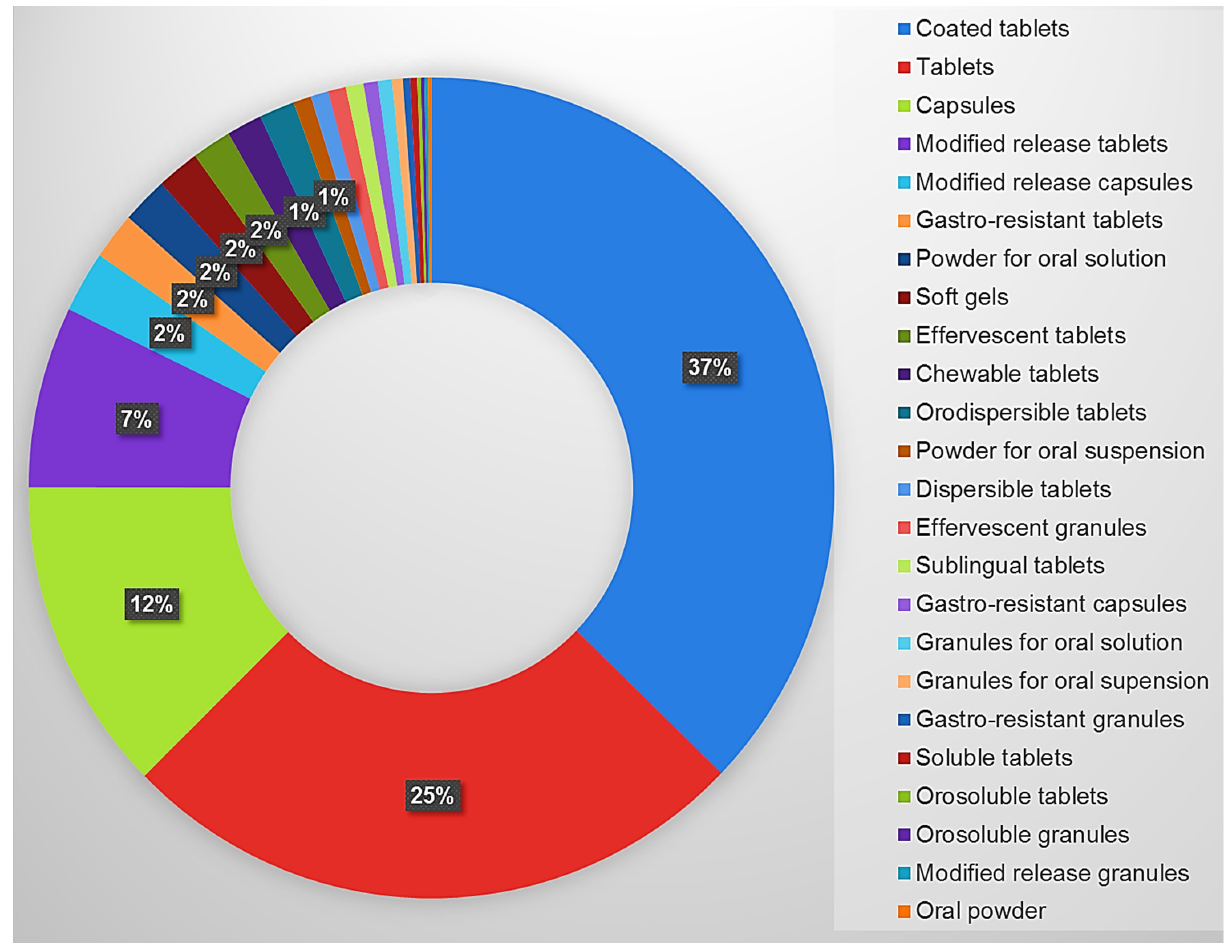
Figure 2. Solid oral dosage forms included in the Savona hospital